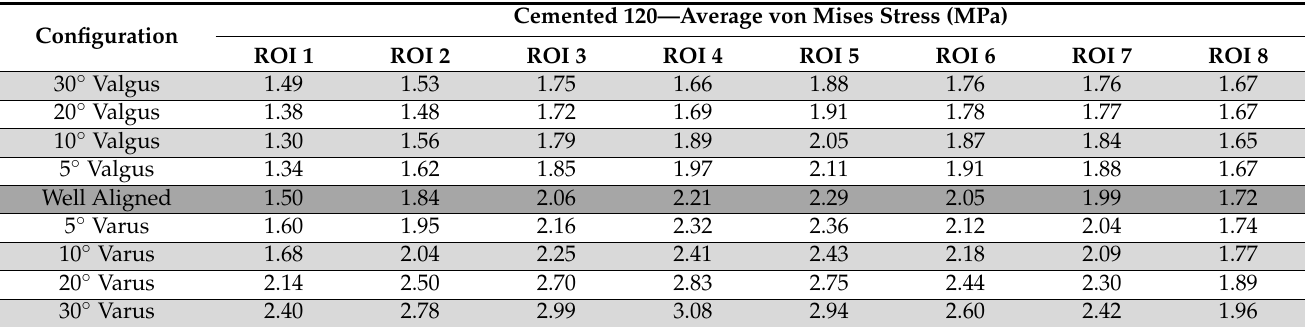
Table 9. Average von Mises stresses in the different ROIs for the 120 mm cemented